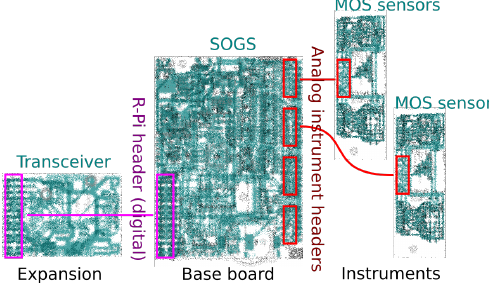
Figure 4. Small Open General purpose Sensor (SOGS) daughterboard example configuration. This diagram shows the base board, an expansion board (through the digital Raspberry Pi header) and instrument boards (through the analogue headers). Multiple boards can be stacked through the digital header, and up to four different analogue instruments can be connected. Each instrument board connector carries power and eight analogue